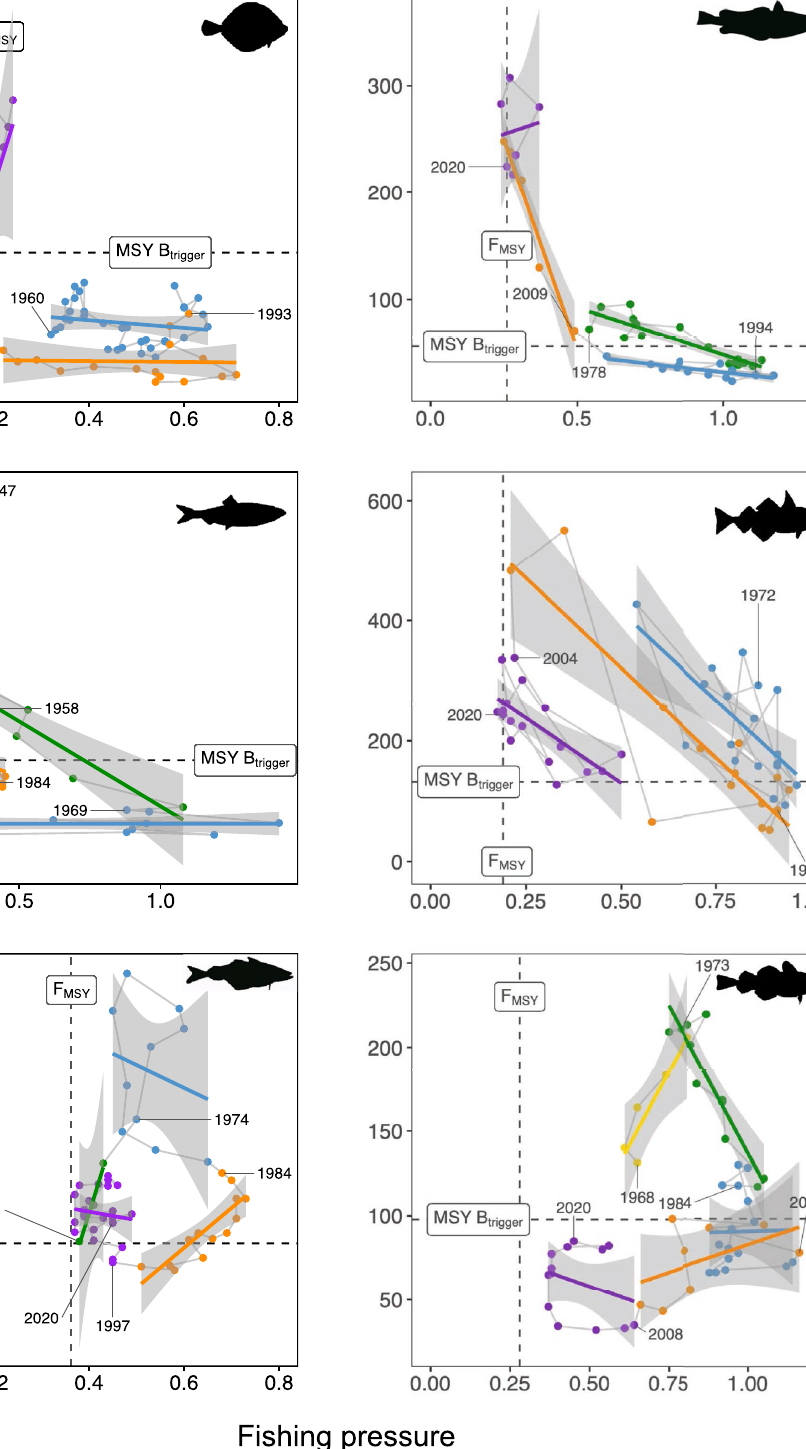
Figure 2. Hysteresis in North Sea fish stocks. Vertical and horizontal lines show sustainable fishing pressure (F MSY ) and the level of spawning stock biomass (SSB) triggering specific action in management (MSY B trigger ), respectively. Coloured points show SSB periods identified by break point analyses (see also Table 1). Time lags (F t−n ) of 3, 4, and 5 years were used for plaice, saithe and cod,